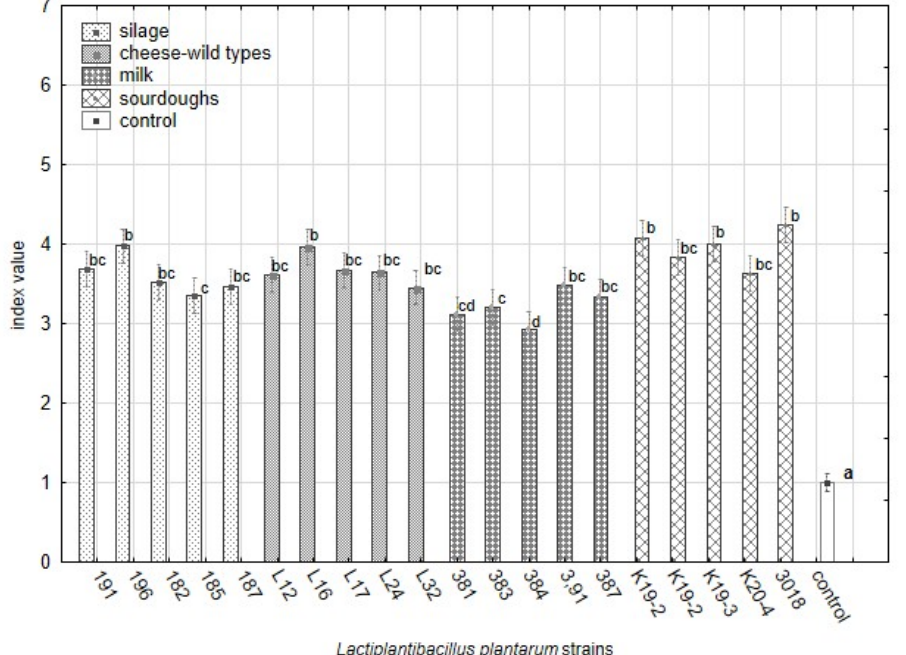
Figure 3. The variability in the antifungal effect against 25 yeast strains among L. plantarum strains from different origins based on index scale values from the overlay method. The data represent the means and SEM (ANOVA, Statistica v. 12, Post Hoc Tukey’s HSD Test). The index letter indicates significant differences. Significant at α ≤ 0.05.